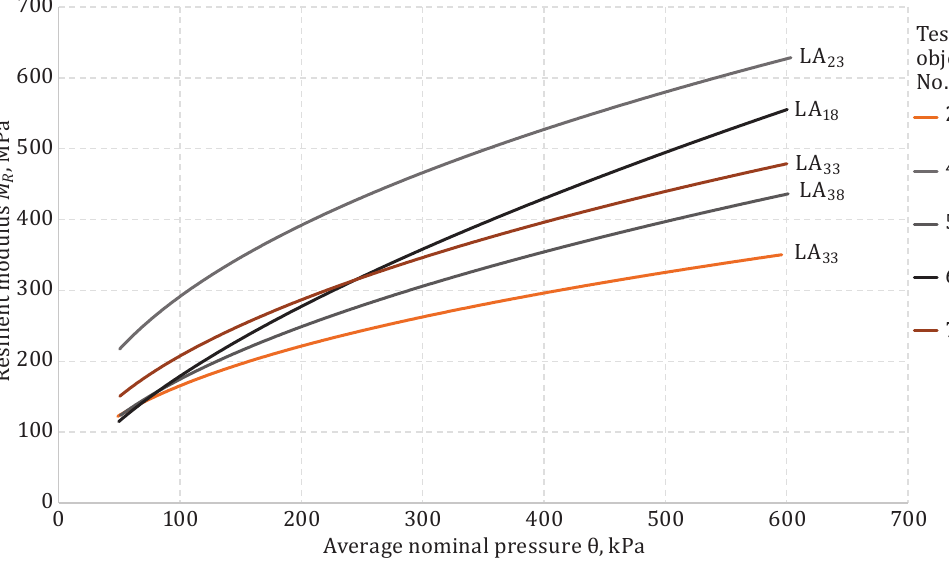
Figure 5. Effect of the aggregate resistance to fragmentation on resilient modulus within different average nominal